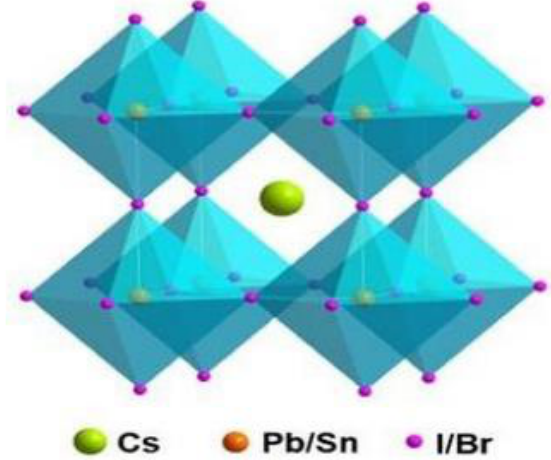
Figure 5. Schematic structure of CsPbX 3 perovskite [45] .